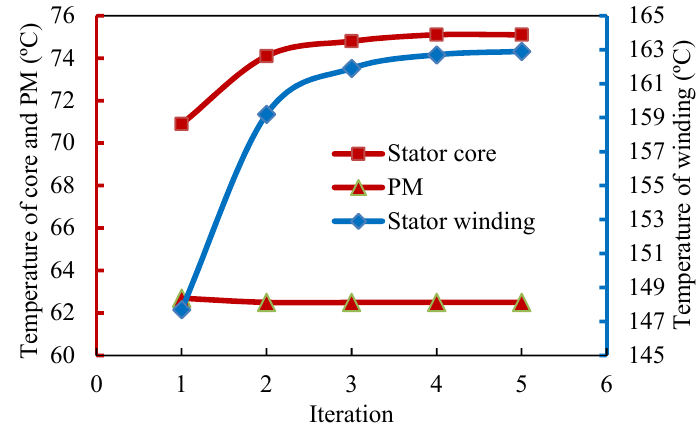
Figure 21. Average temperature vs. iteration.